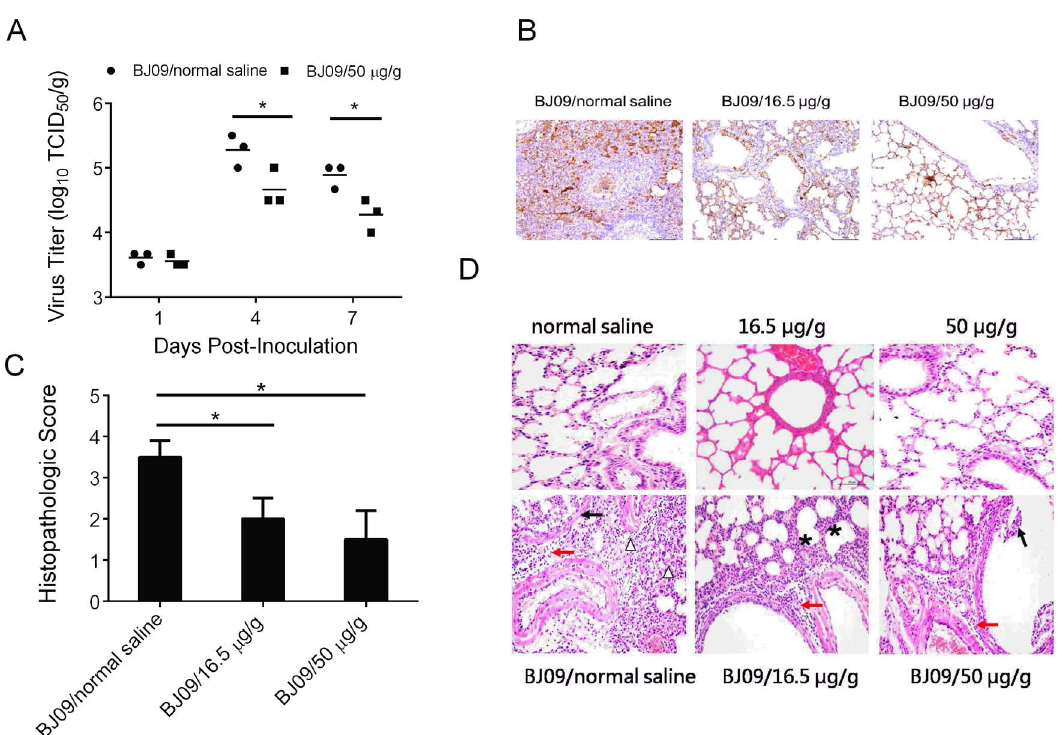
Figure 4. Cryptoporus volvatus extract inhibits H1N1 influenza virus replication in vivo , and reduces severity of pathological changes. (A) Virus replication in lung of mice. Titers of virus recovered from the supernatant of homogenized lung at day 1, 4, and 7 p.i. are shown. (B) Immunohistochemistry analysis of the lung of influenza virus-infected mice treated with normal saline or the extract. Scale bars, 100 m m. (C) Lung histological grading of virus- infected mice treated with normal saline or the extract (5 sections from each lung, and 3 mice per group). (D) Representative of histopathological changes in H&E stained lung tissues from mice sacrificed at day 4 p.i.. normal saline (negative control group); 50 m g/g (extract control group), no histopathology lesion; BJ09/normal saline (virus infection control group): severe desquamation and droplet of bronchial mucosa ( q ), massive immune cell and red blood cell infiltrates around bronchi and blood vessels (red arrow), and inflammatory cells within alveolar spaces ( g ); BJ09/16.5 m g/g (virus infection and treated with low-dosage extract group): a small number of immune cell infiltrates around bronchi and blood vessels (red arrow), and alveolar wall thickened (*); BJ09/ 50 m g/g (virus infection and treated with high-dosage extract group): a small number of immune cell infiltrates around bronchi and blood vessels (red arrow), and mild desquamation of bronchial mucosa ( q ). (Scale bar: 50 m m). Data are presented as mean ¡ SD. Statistical significance was analyzed by Student ’ s t test ; * P , 0.05 ; ** P , 0.01 .